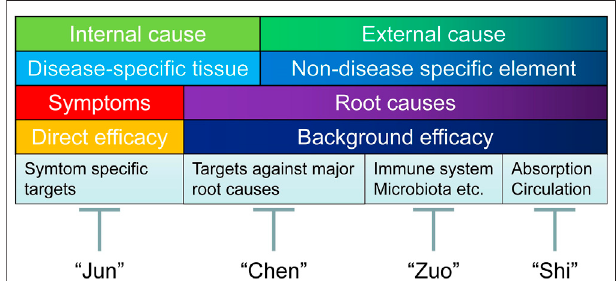
FIGURE 3 | Holistic treatment strategy integrating dCloud and TCM combinational treatment regimen. Above fi gure illustrated a holistic